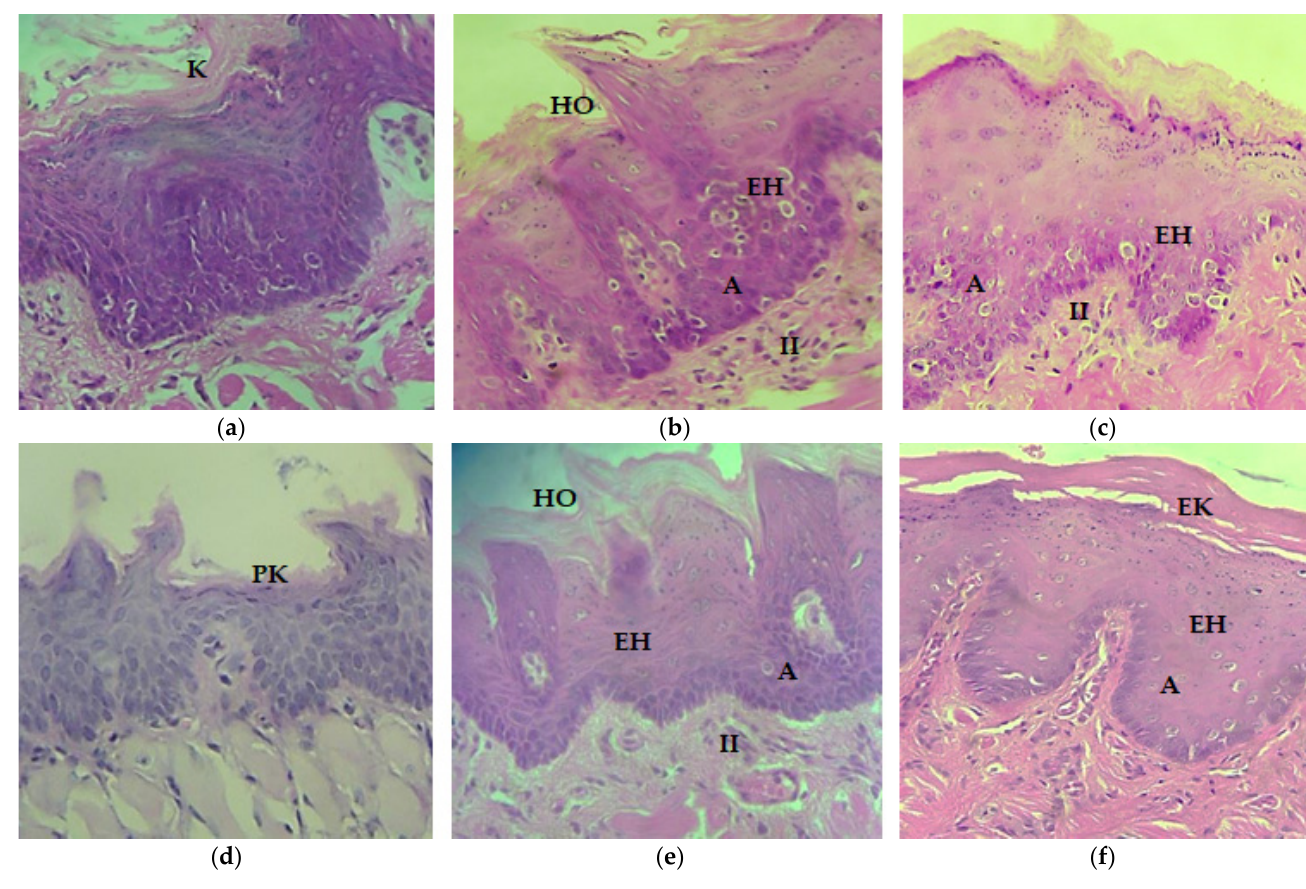
Figure 2. Histological modifications of the lingual tissue with hematoxylin–eosin (H&E) staining (40×). ( a ) Female control group, ( b ) female group 40% alcohol consumption, ( c ) female group 5% alcohol consumption, ( d ) male control group, ( e ) male group 40% alcohol consumption, and ( f ) group of males consuming 5% alcohol. PK, parakeratinized; K, keratinized; HO, hyperorthokeratinized; HK, hyperkeratinized; EH, epithelial hyperplasia; A, acanthosis; II, inflammatory infiltrate; V, blood vessels.